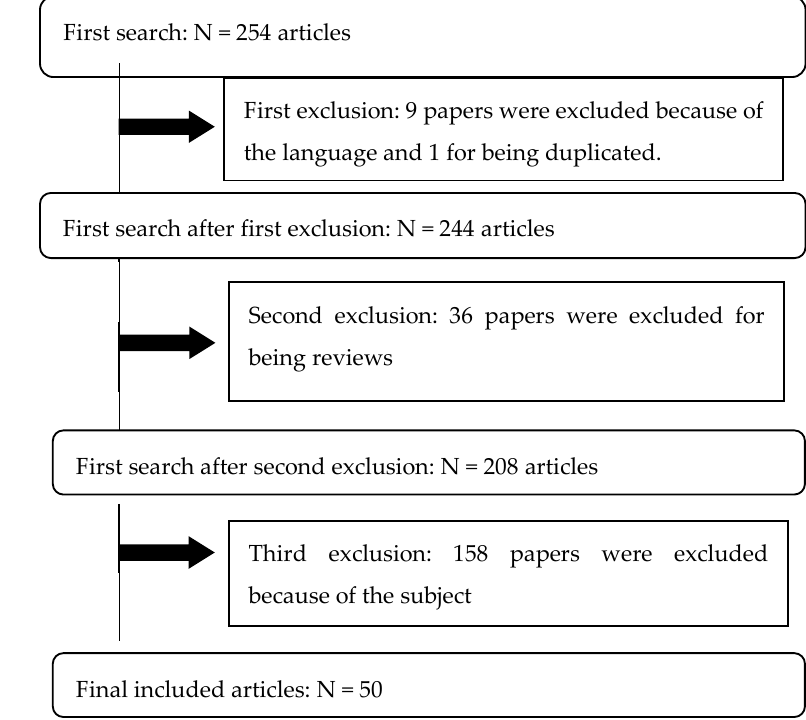
Figure 1. Data Collection for the study.